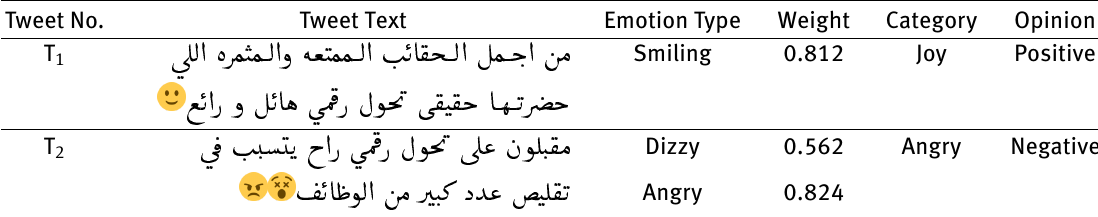
Table 4: Instances of tweets having emotions. Tweet